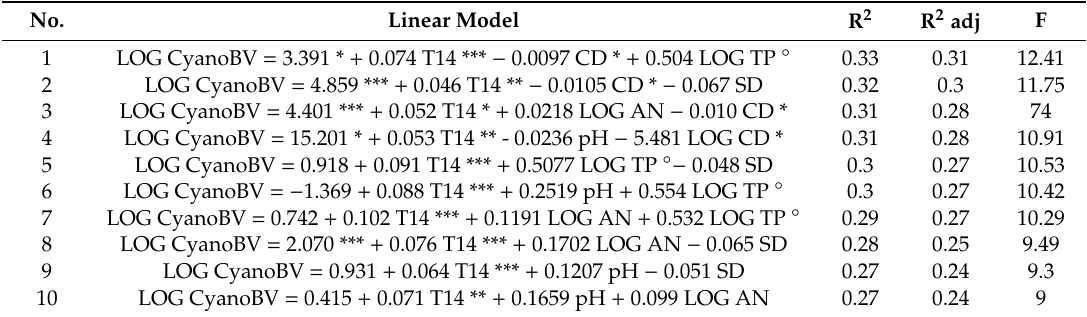
Table A4. Three-variable multiple linear regression (MLR) models of cyanobacteria biovolume (LOG CyanoBV) using the 14-days mean atmospheric temperature (T14) and two of the physical–chemical variables (AN: Ammonium nitrogen; CD: Conductivity; TP: Total phosphorous; SD: Secchi disk depth; and pH). The statistical significance of each coe ffi cient is indicated when below 0.1 ( p -values: ***: 0.001; **: 0.01; *: 0.05; ◦ , 0.1). For each model the coe ffi cient of determination (R 2 ), the adjusted R 2 (R 2 adj), and the F statistic are reported. LOG means 10-based